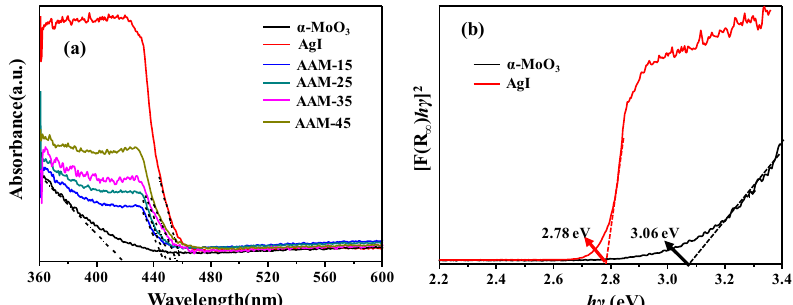
Figure 4. ( a ) UV-vis absorbance spectra of pure α -MoO 3 , AgI and AAM heterojunctions with di ff erent mass percent of initially formed AgI content, ( b ) the plots of [F(R ∞ ) h γ ] 2 versus h γ of α -MoO 3 , AgI. Photoluminescence (PL) spectrum and electrochemical impedance spectroscopy (EIS) are widely used to monitor the separation and transfer e ffi ciencies of the photogenerated charge carrier. For the PL spectrum, the high emission intensity implies a high recombination rate of the photogenerated charge carrier [48]. For pure α -MoO 3 nanobelts, AgI, and AAM-35, the PL emission intensity of AAM-35 depicted in Figure 5a was weaker than that of pure α -MoO 3 nanobelts and AgI, indicating that the modification of Ag / AgI on the surface of α -MoO 3 nanobelts e ffi ciently improved the separation of + − photogenerated e and h . Moreover, the arc size of the AAM-35 from the EIS results was smaller than that of the α -MoO 3 nanobelt and AgI, further suggesting that AAM-35 possessed smaller charge-transfer resistance is in favor of photogenerated charge carrier transfer. This result is consistent with the PL Nanomaterials 2019 , 9 , x FOR PEER REVIEW property of AAM-35 [49].